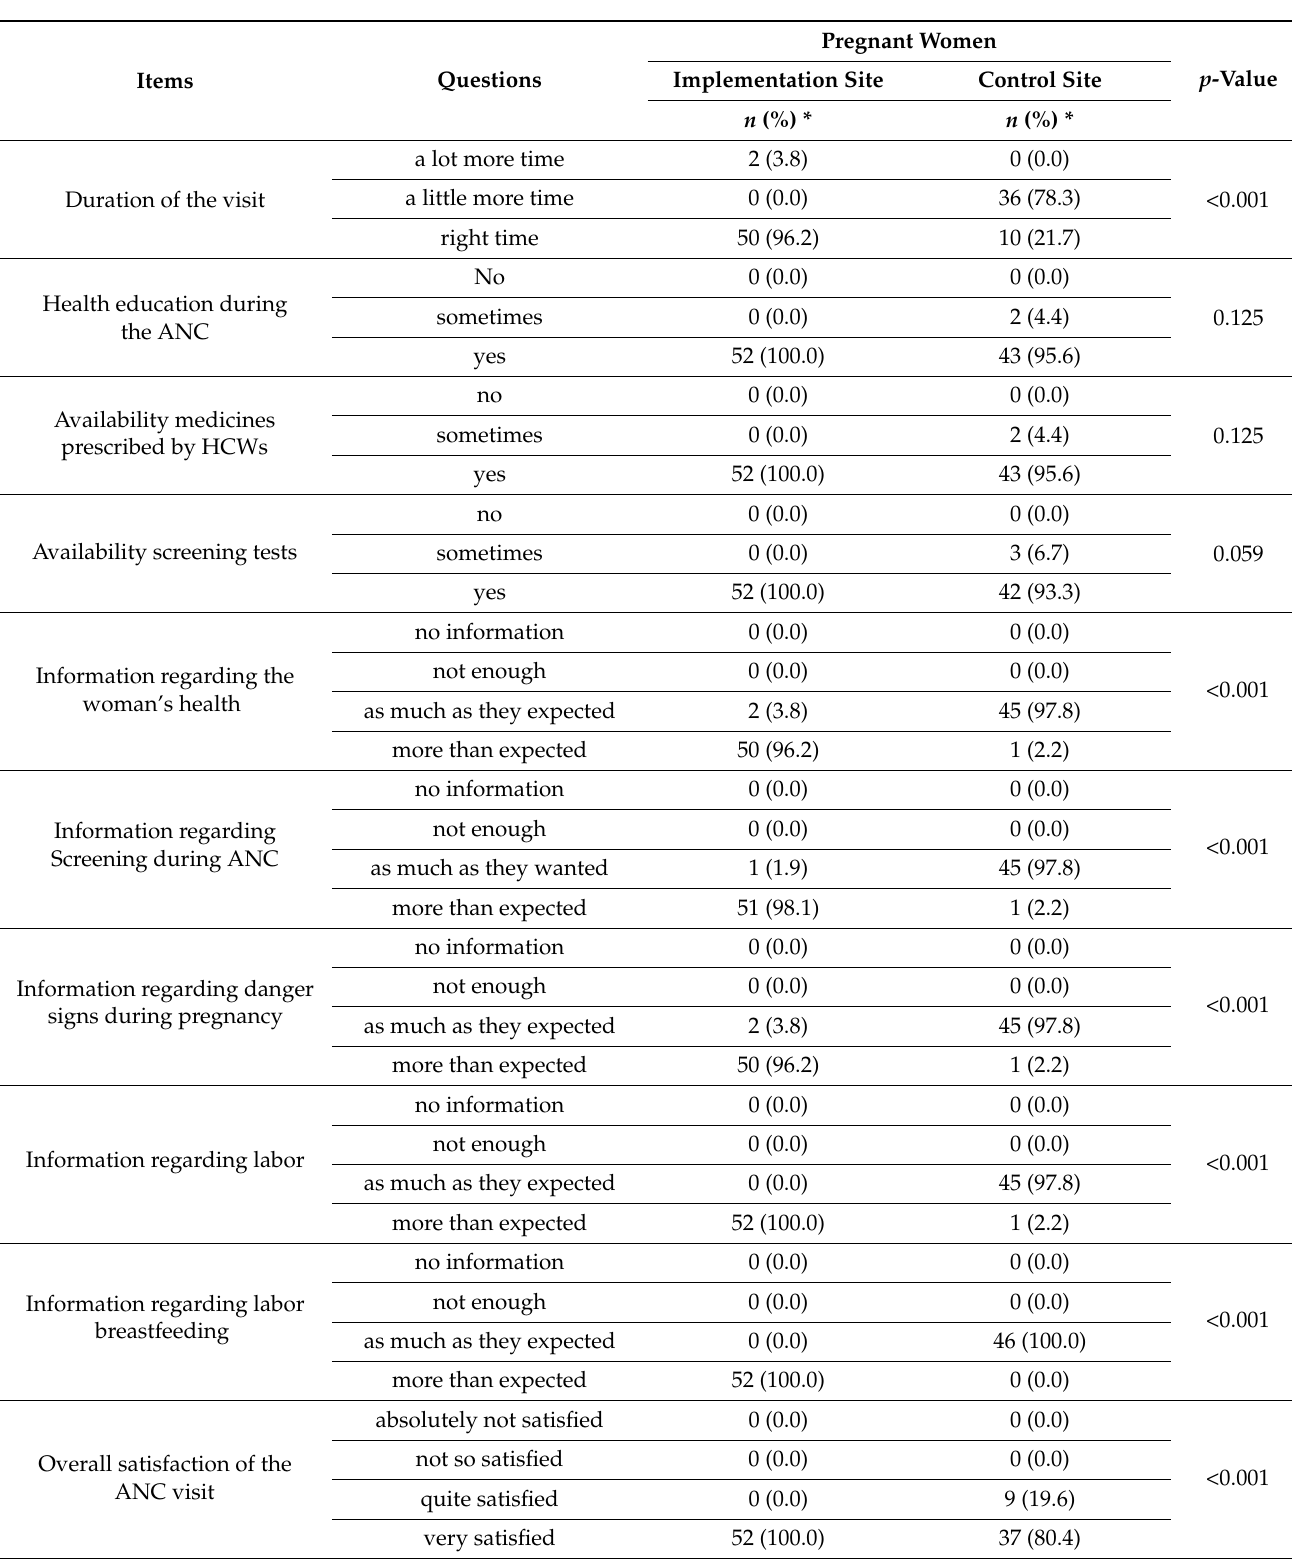
Table 1. ANC acceptability assessment of pregnant women by area (implementation area ( n = 52) and control area ( n =